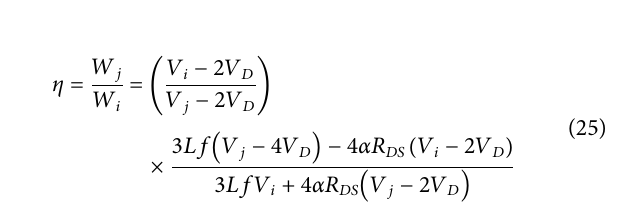
FIGURE 4 | Flow chart of the adaptive balancing control